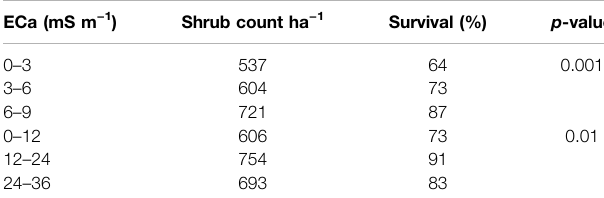
TABLE 4 | Shrub survival count based on inverted EC mapped